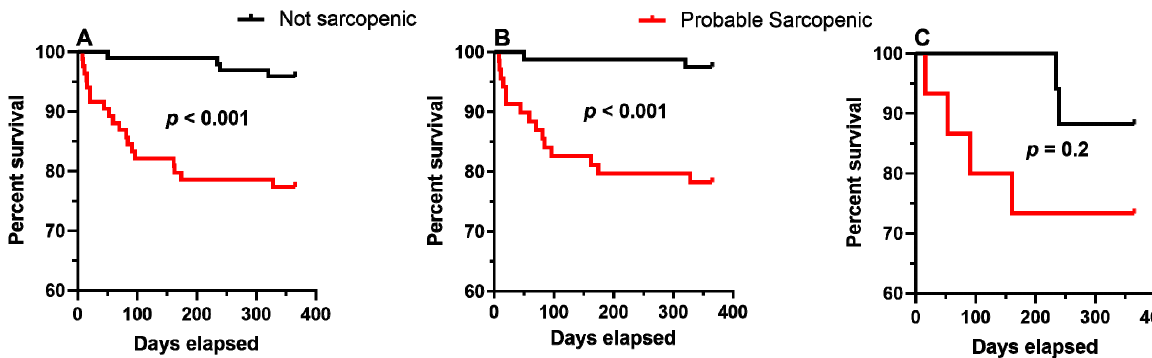
Figure 2. One-year survival curves of patients with hip fracture and a probable sarcopenic status according to muscle strength measures; ( A ) all patients, ( B ) knee-extension strength, ( C ) hand grip strength.